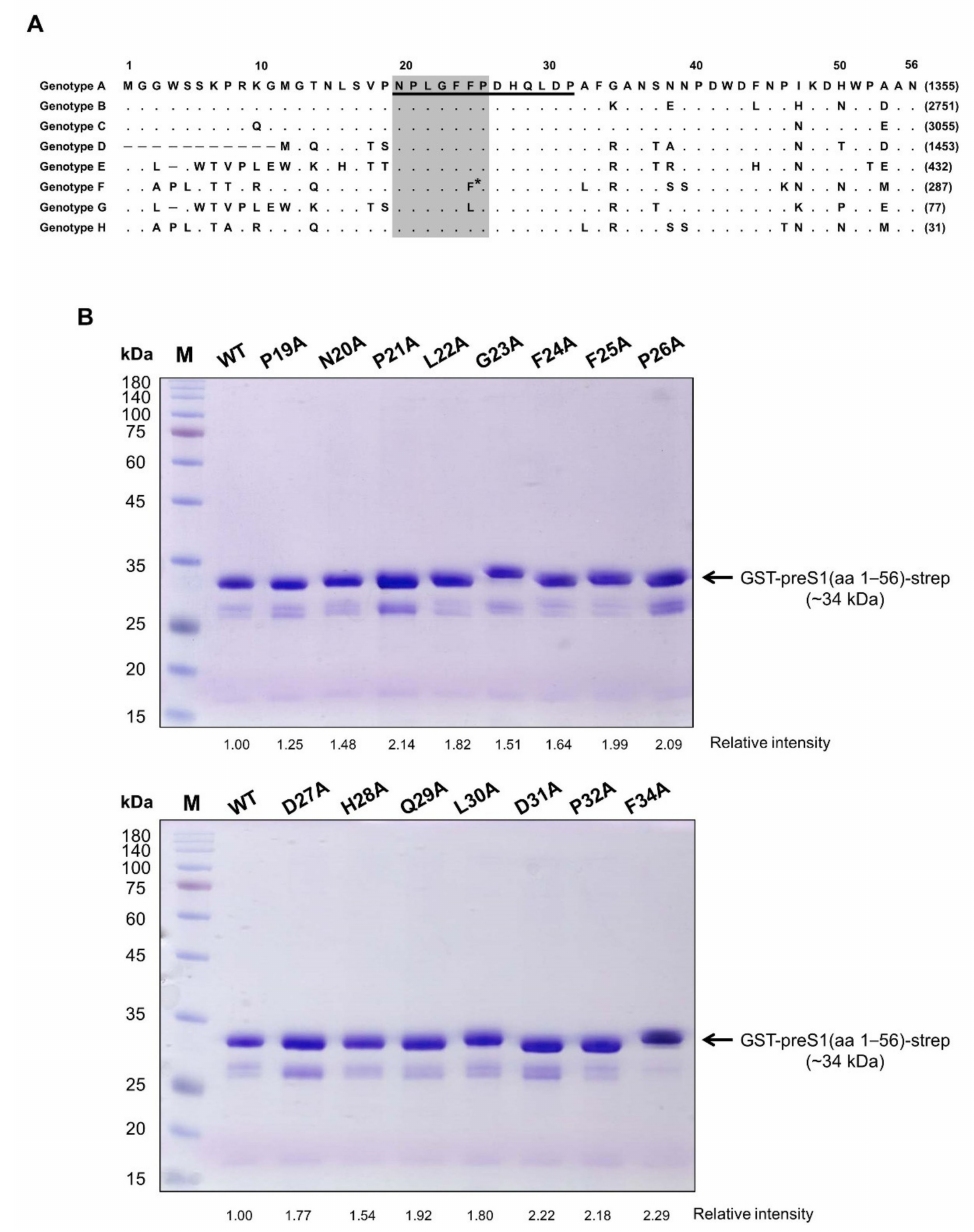
Figure 1. ( A ) Sequence alignment of preS1 (aa 1–56) of genotypes A–H. The number of identical sequences among the total 9639 preS1 genes in the Hepatitis B Virus Database, available online: https://hbvdb.lyon.inserm.fr/HBVdb/ (accessed on 28 May 2021) are written in parentheses after the amino acid sequences. A dot indicates an amino acid residue identical to that of genotype A, while a hyphen represents a deletion. In the case of genotype F, 81.53% and 12.47% of this genotype have Phe and Leu at position 25, respectively. The receptor-binding motif is shaded. ( B ) 12% SDS–PAGE of the purified GST–preS1 (aa 1–56)–strep with an alanine substitution at aa 19–34. The wild type (WT; genotype C) was included as a control. M, molecular weight